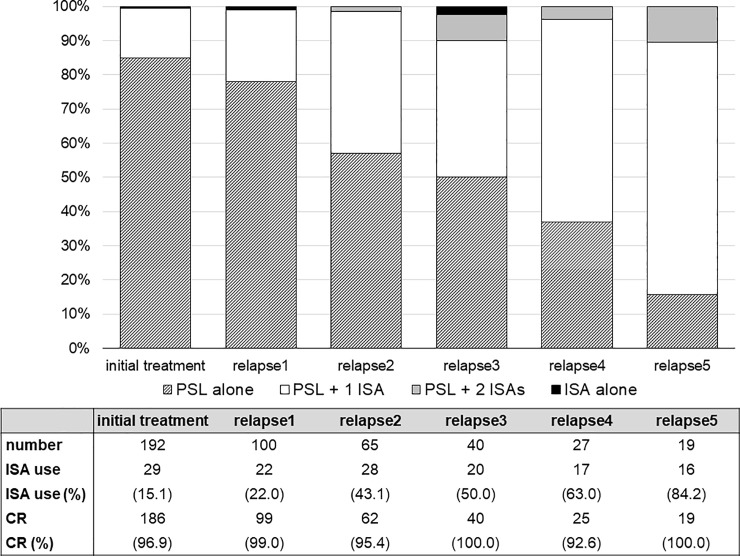
Demographic pattern of immunosuppressive treatment for adult minimal change disease relapses.Proportion of steroid and other immunosuppressive drugs use in treatment of adult MCD from initial treatment to fifth relapse are shown in bar-graphs. The details about types of used non-steroidal immunosuppressants are summarized in S4 Table. Abbreviations: MCD, minimal change disease; PSL, prednisolone; ISA, non-steroidal immunosuppressive agents; CR, complete remission.